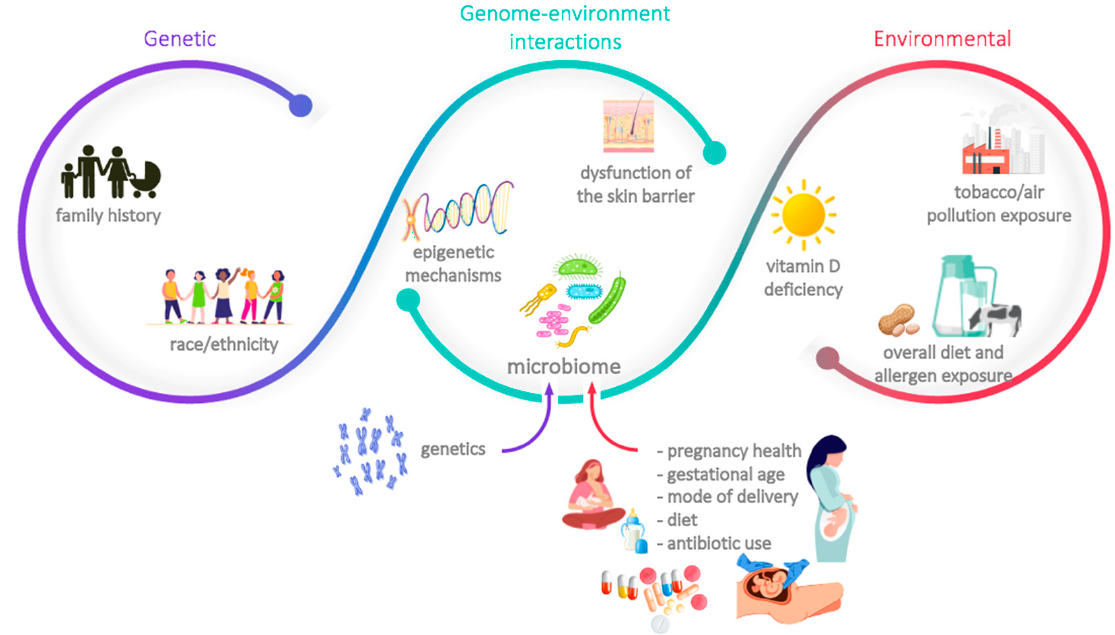
Figure 1. Main risk factors associated with the development of allergies.